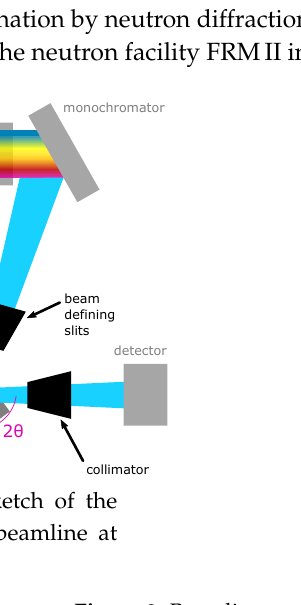
Figure 2. Beamline setup and measurement